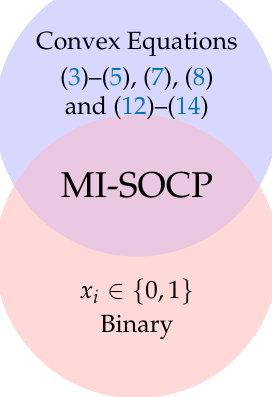
Figure 2. Mixed-integer second-order cone programming (SOCP) equivalent model for the problem of the optimal location and sizing of distributed generators in distribution